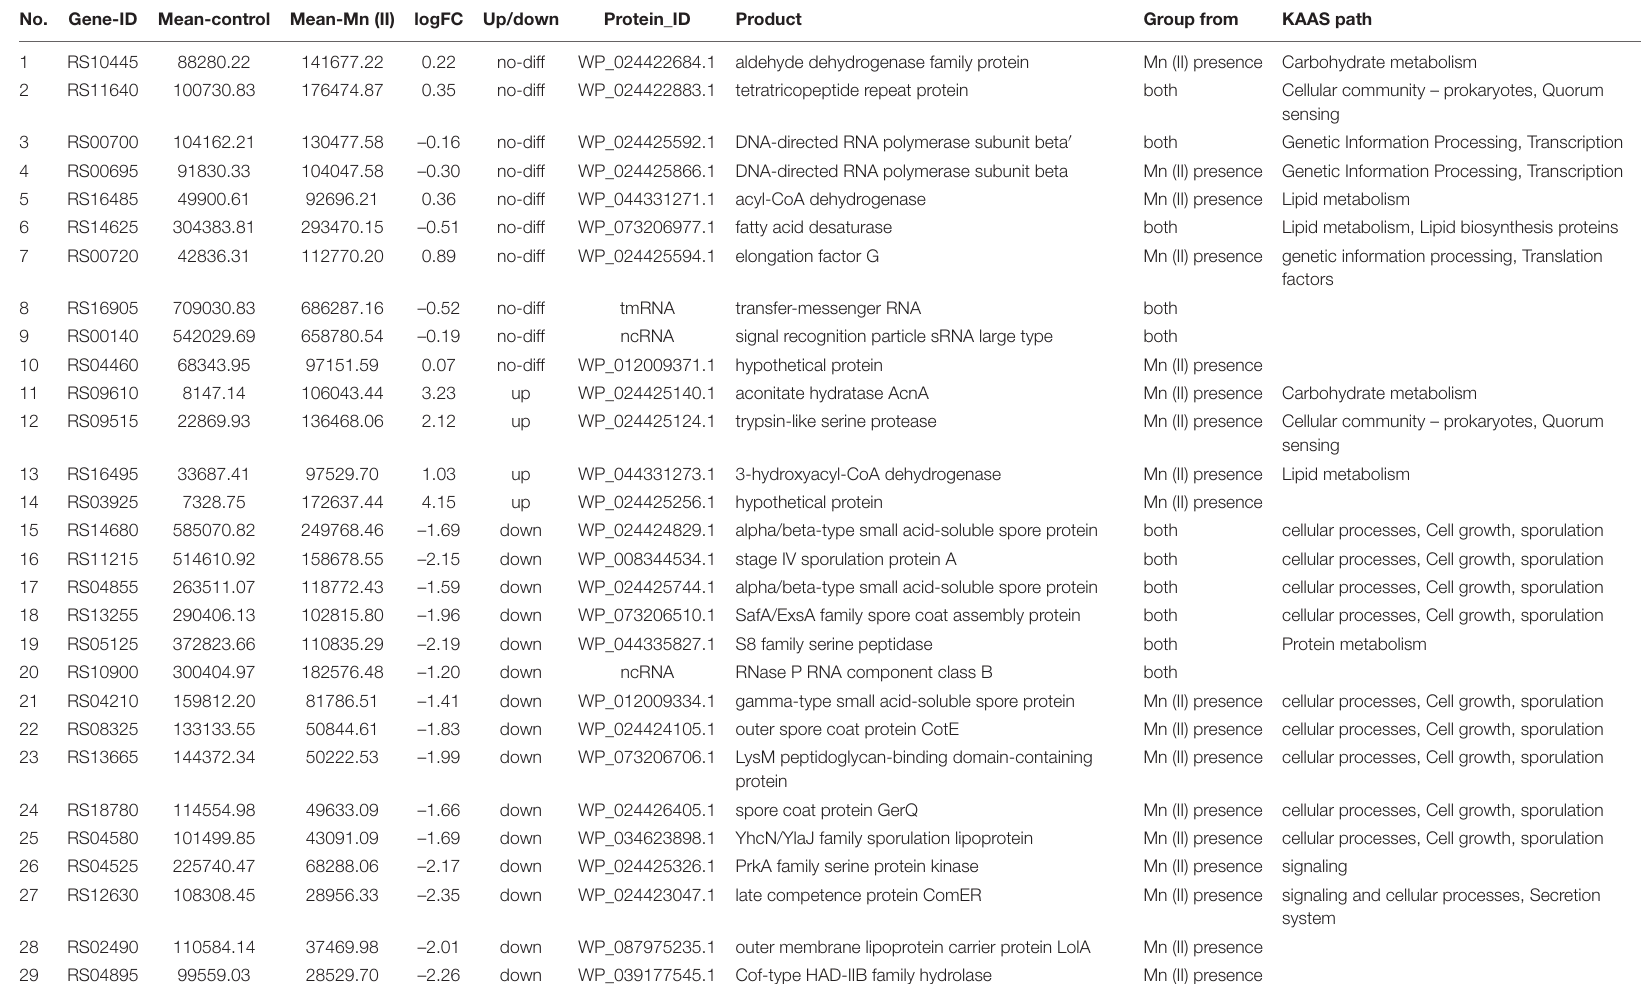
TABLE 2 | Top 20 highly expressed genes in the mid-exponential growth phase of strain ST7. No. Gene-ID Mean-control Mean-Mn (II) logFC Up/down Protein_ID Product Group from KAAS